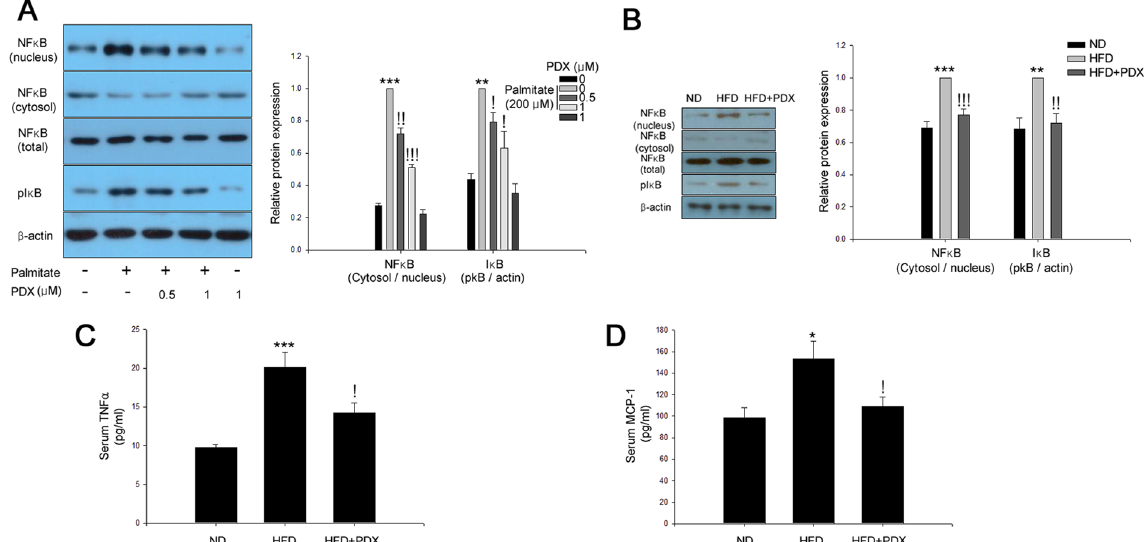
Figure 3. PDX ameliorates inflammation in skeletal muscle cells. ( A ) Western blot analysis of palmitate- induced NFkB nuclear translocation and IkB phosphorylation in differentiated C2C12 cells treated with 200 μ M palmitate and PDX (0–1 μ M) for 24 hr. ( B ) Western blot analysis of HFD-induced NFkB nuclear translocation and IkB phosphorylation in soleus skeletal muscle of mice treated with PDX (1 μ g/mouse/day) for 8 weeks. Serum analysis of ( C ) TNF α and ( D ) MCP-1 of mice treated with HFD and PDX (five animals per treatment group). Means ± SEM were calculated data obtained from five separated animals. *** P < 0.001 and ** P < 0.01 when compared to the control or the ND treatment. !!! P < 0.001, !! P < 0.01, and ! P < 0.05 when compared to levels in the palmitate or the HFD